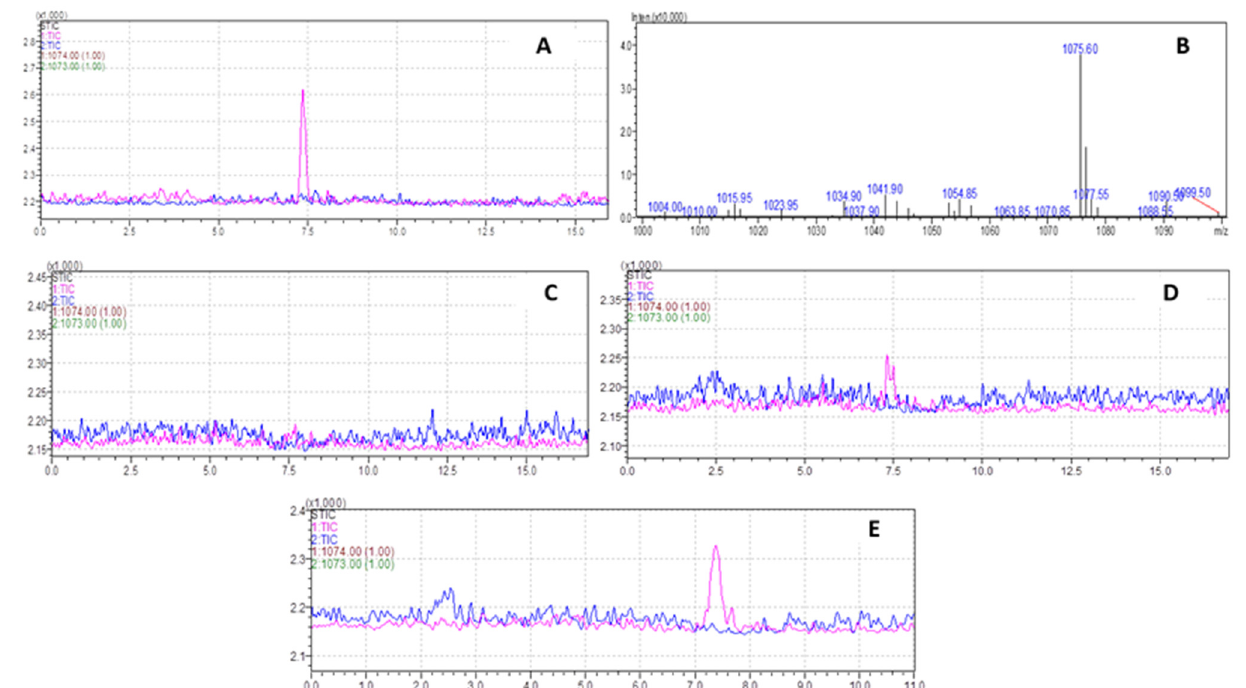
Figure 5. Characterization of METH–(KG) 5 conjugates by LC-MS. ( A ) METH–(KG) 5 in SIM mode, ( B ) METH–(KG) 5 in scan mode, ( C ) blank reaction sample MS spectrum, ( D ) MS spectrum with 300 µg METH in reaction and ( E ) MS spectrum with 1 mg METH in